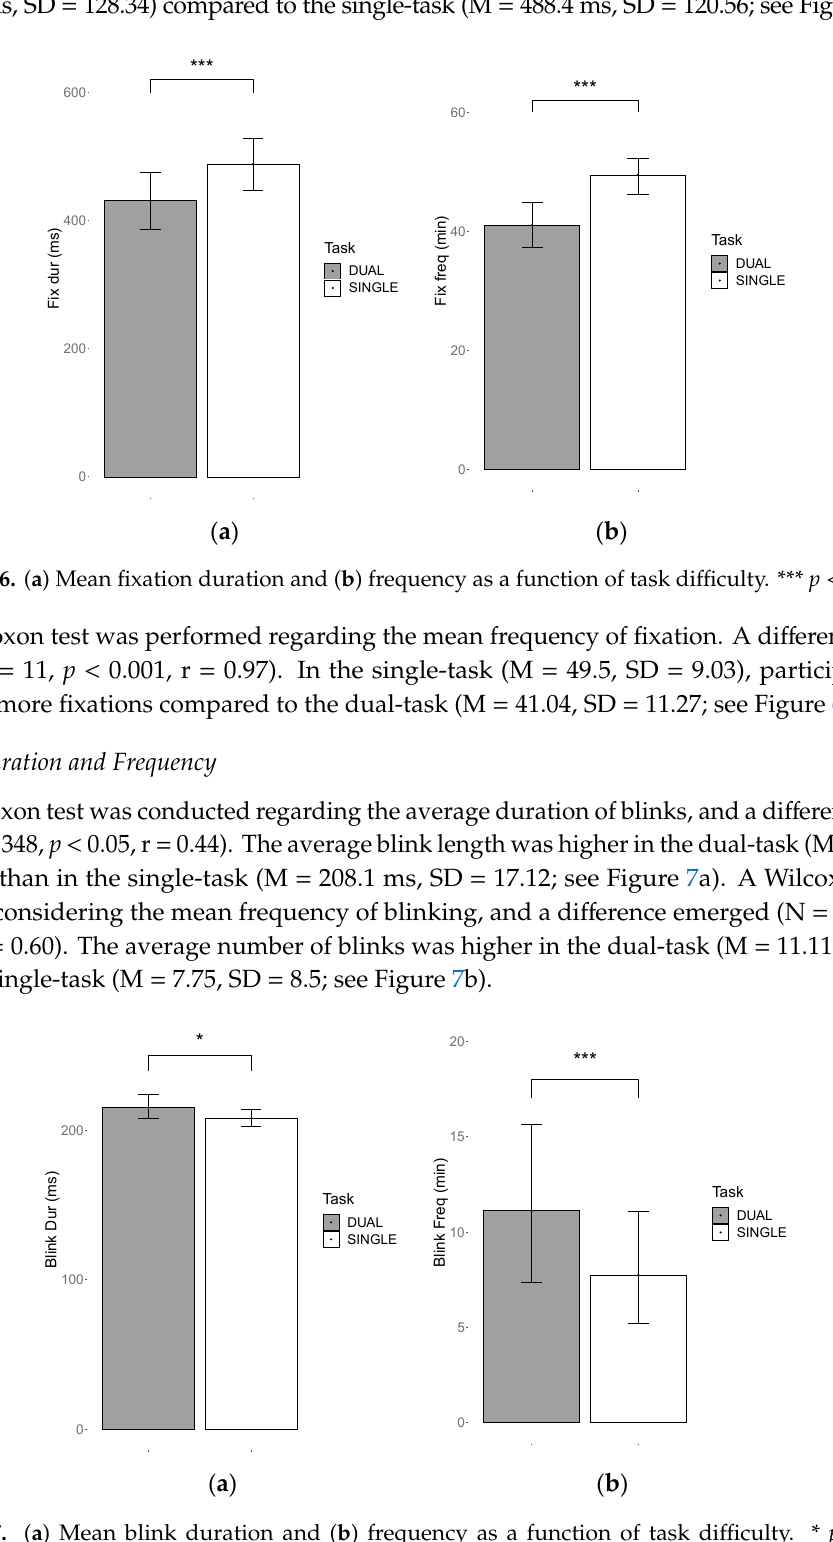
Figure 7. ( a ) Mean blink duration and ( b ) frequency as a function of task difficulty. * p < 0.05. *** p < 0.001.